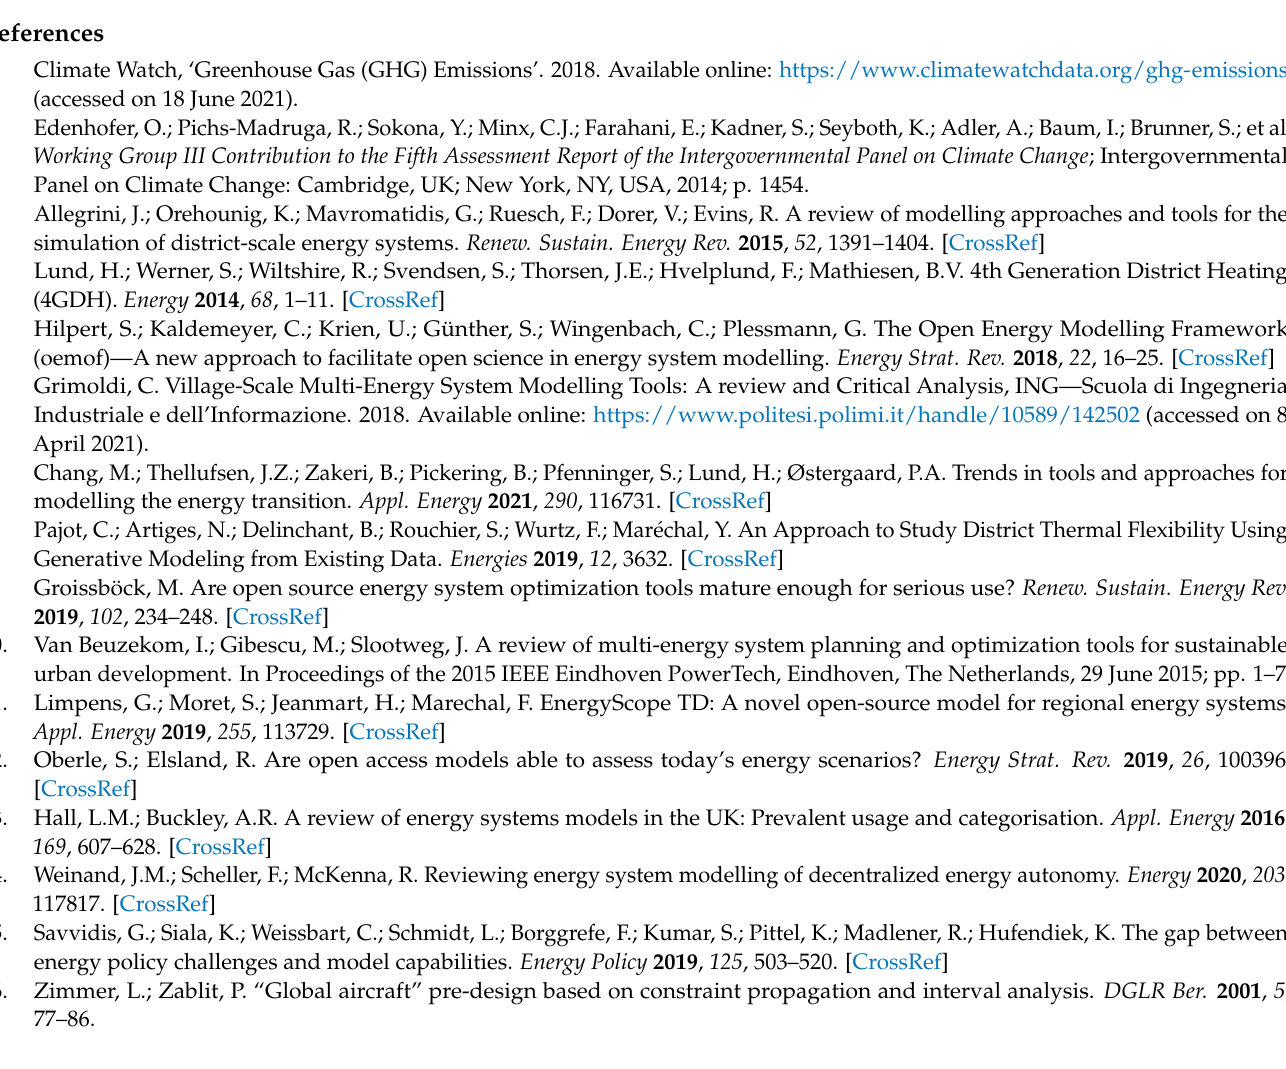
Figure A3. General package UML